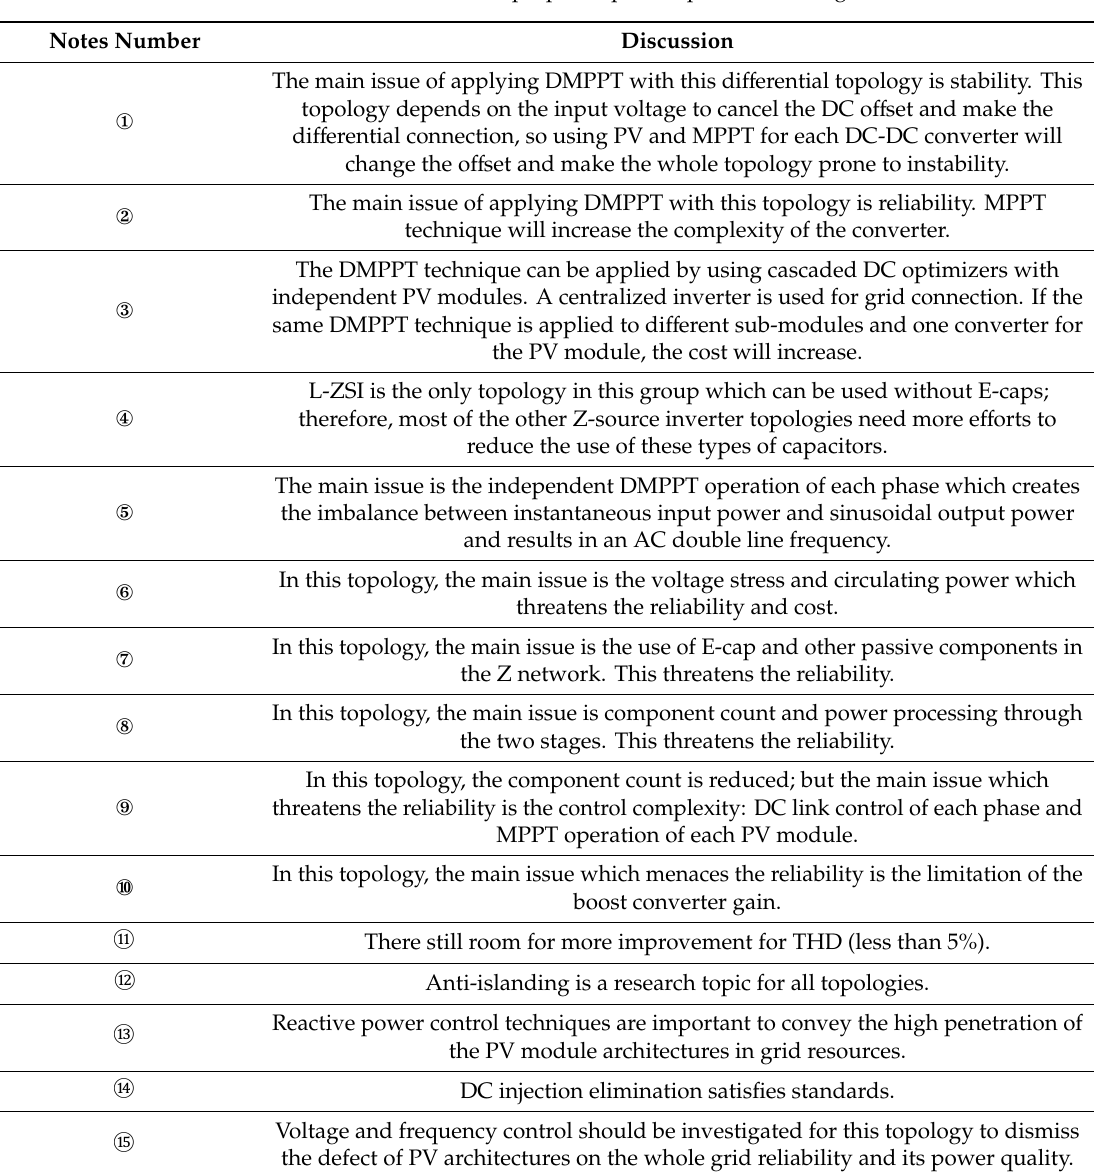
Table 6. The detailed notes of the proposed picture presented in Figure 25.